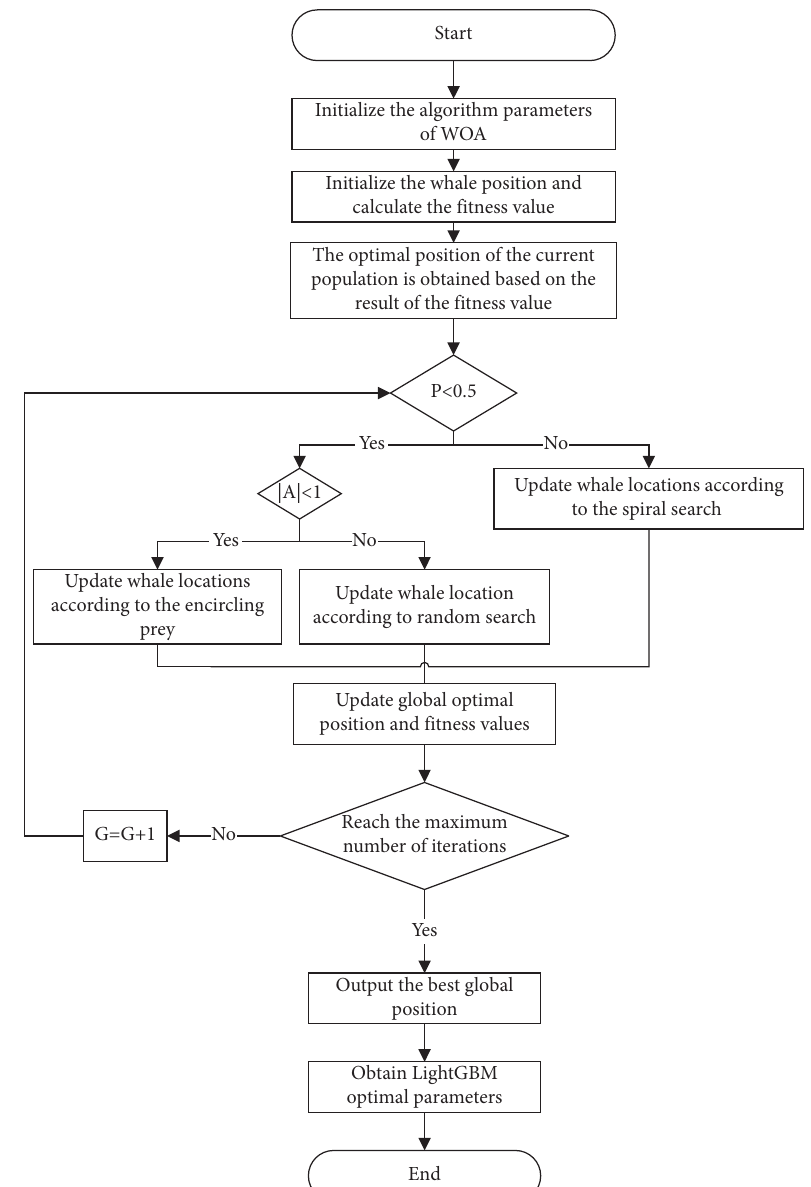
Figure 1: Flow chart of WOA-LightGBM model